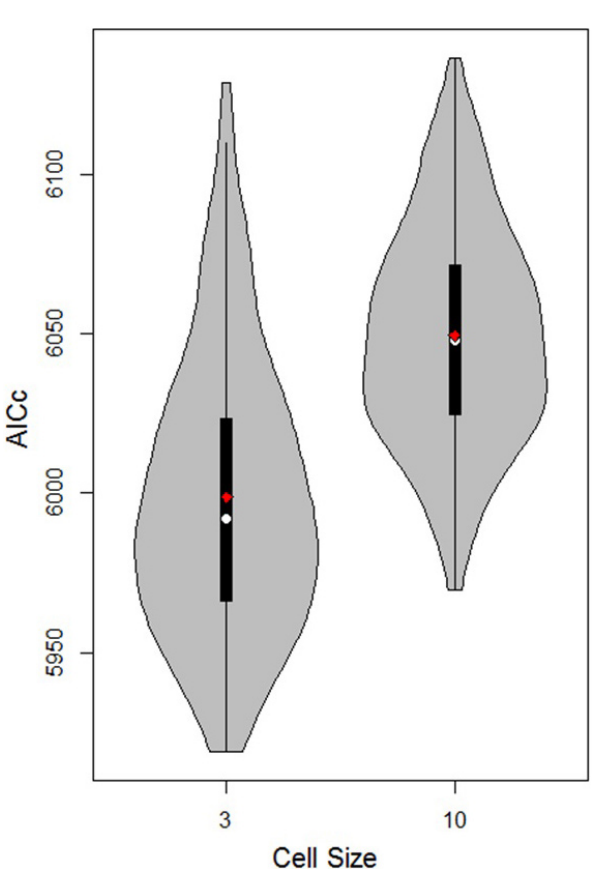
Figure 4. AIC values vs. grid cell size for the lidar data set. Mean and median values are depicted as red diamonds and white dots,